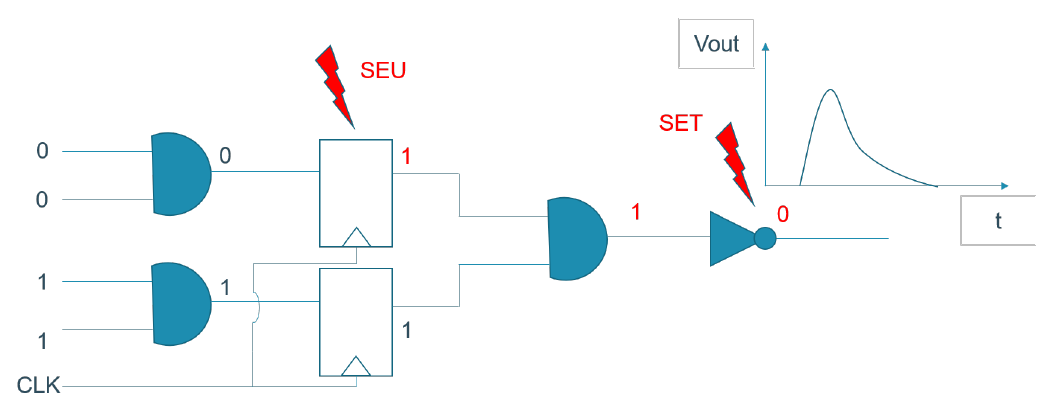
Figure 1. Single Event Transients (SETs) and Single Event Upsets (SEUs) in a digital